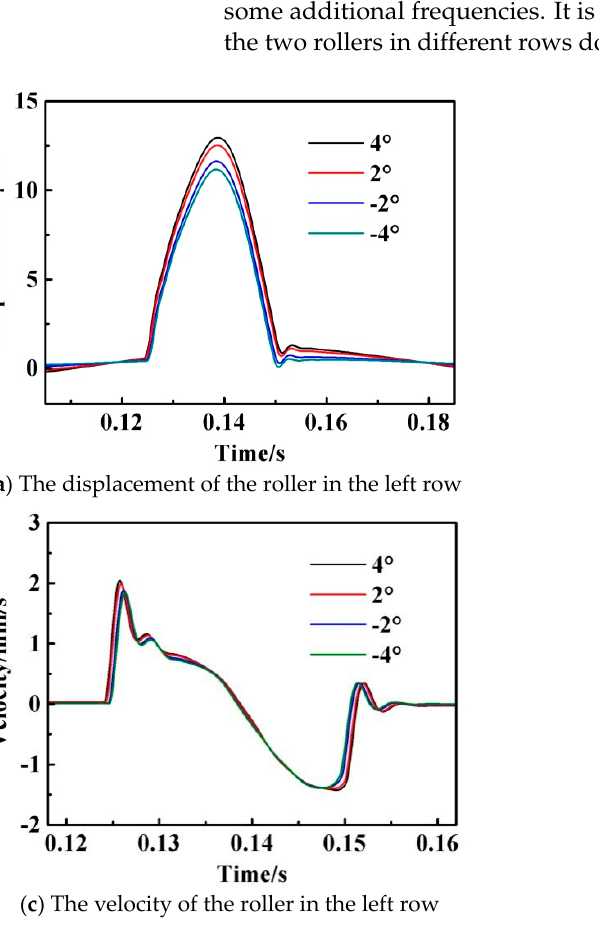
Figure 17. The motion orbit of a roller with varying SAC angles in a revolution period.